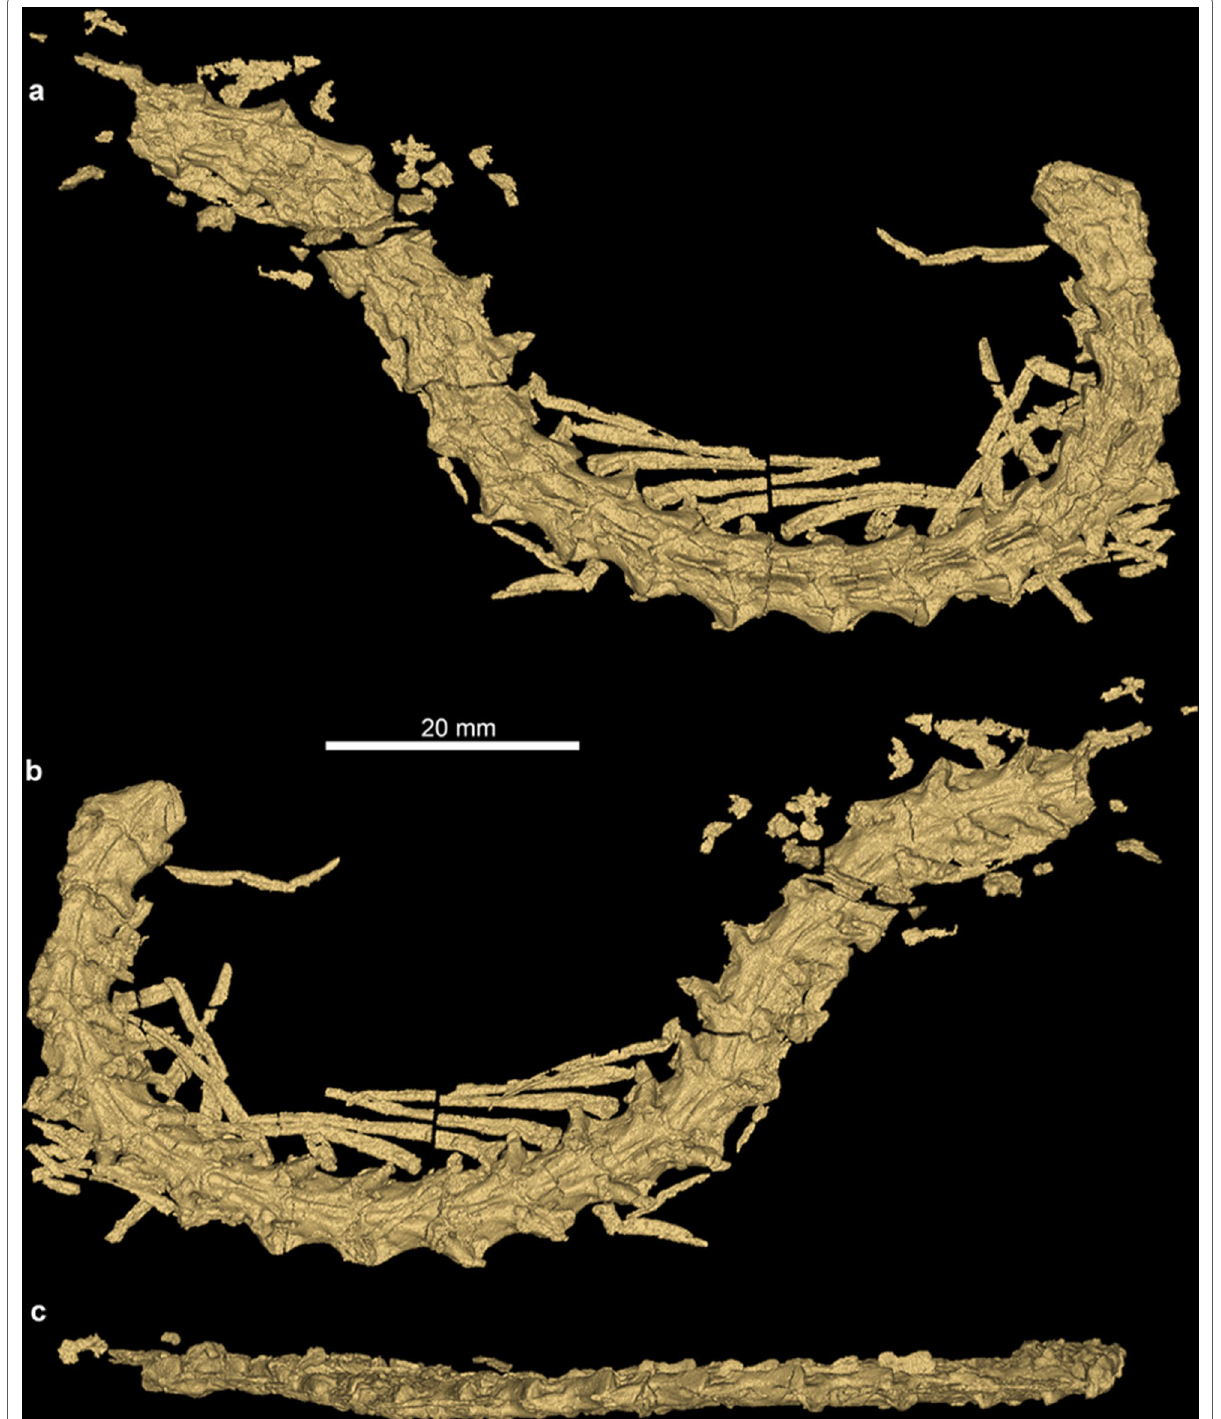
Fig. 2 Colubriformes indet. (PIMUZ A/III 191) from the middle Miocene of Käpfnach, Switzerland. 3D models of the skeleton PIMUZ A/III 191 in dorsal ( a ), ventral ( b ), and lateral ( c )